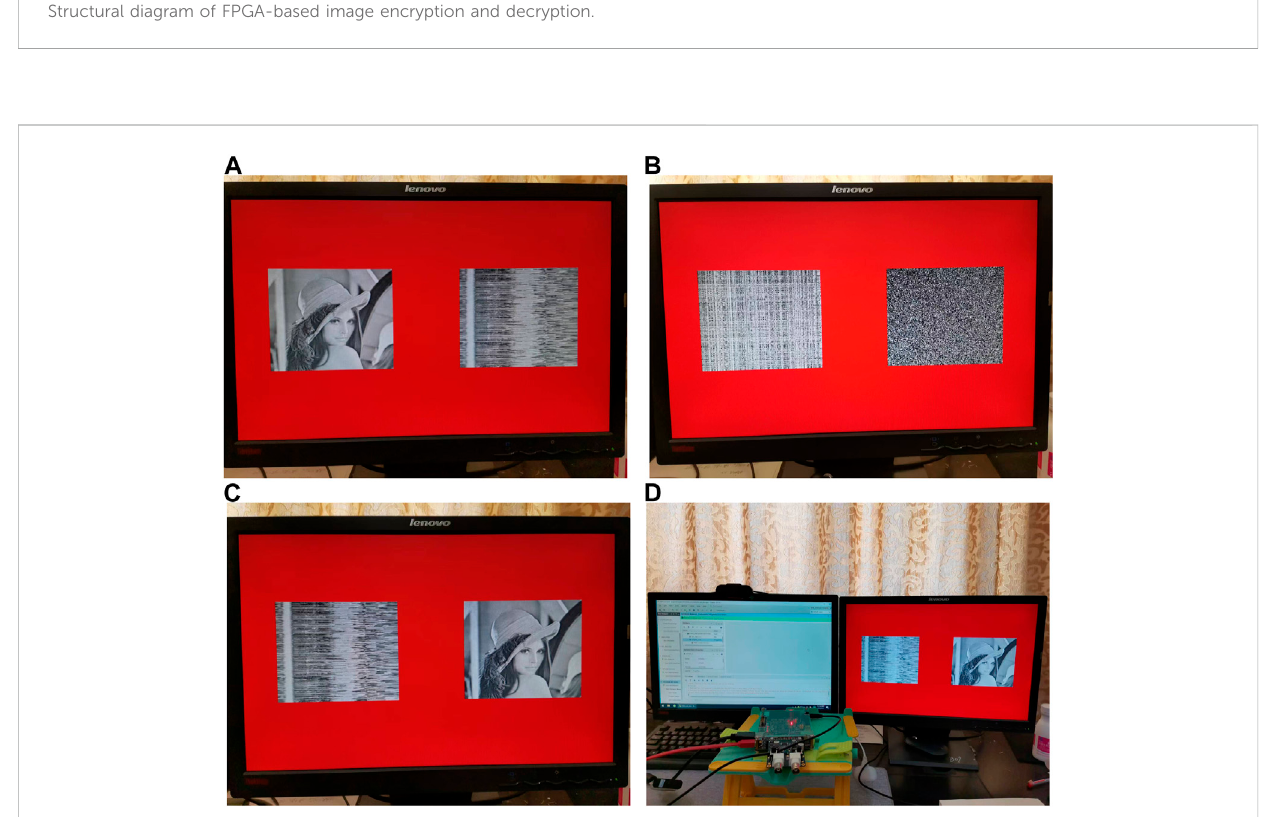
FIGURE 6 FPGA-based implementation results of theproposed image cryptosystem: (A, B) process of image encryption; (C) process of image decryption and (D) experimental equipment and